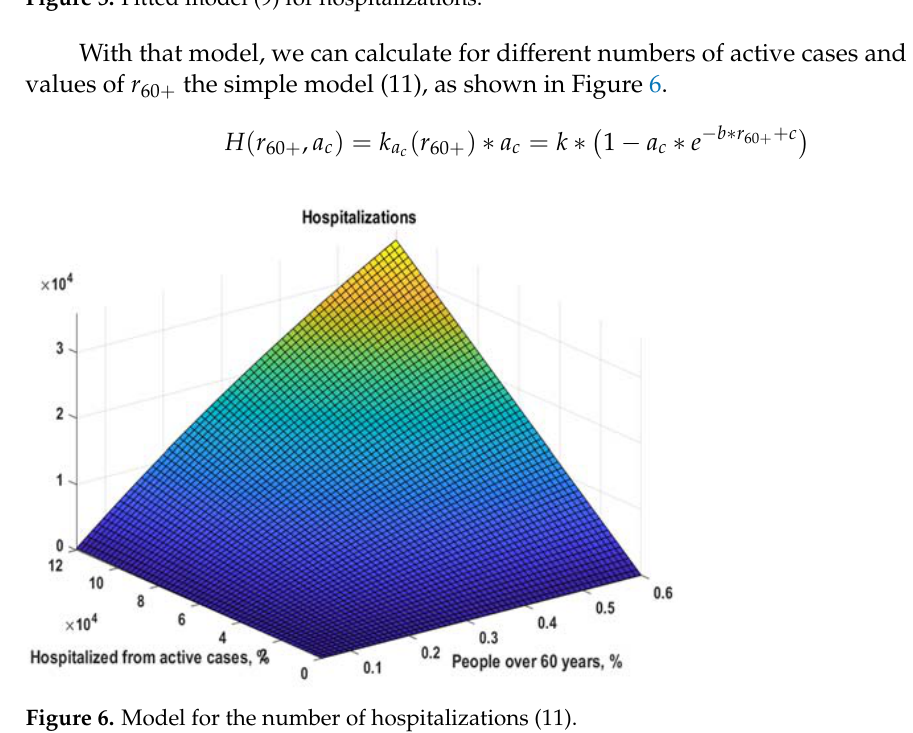
Figure 6. Model for the number of hospitalizations (11).